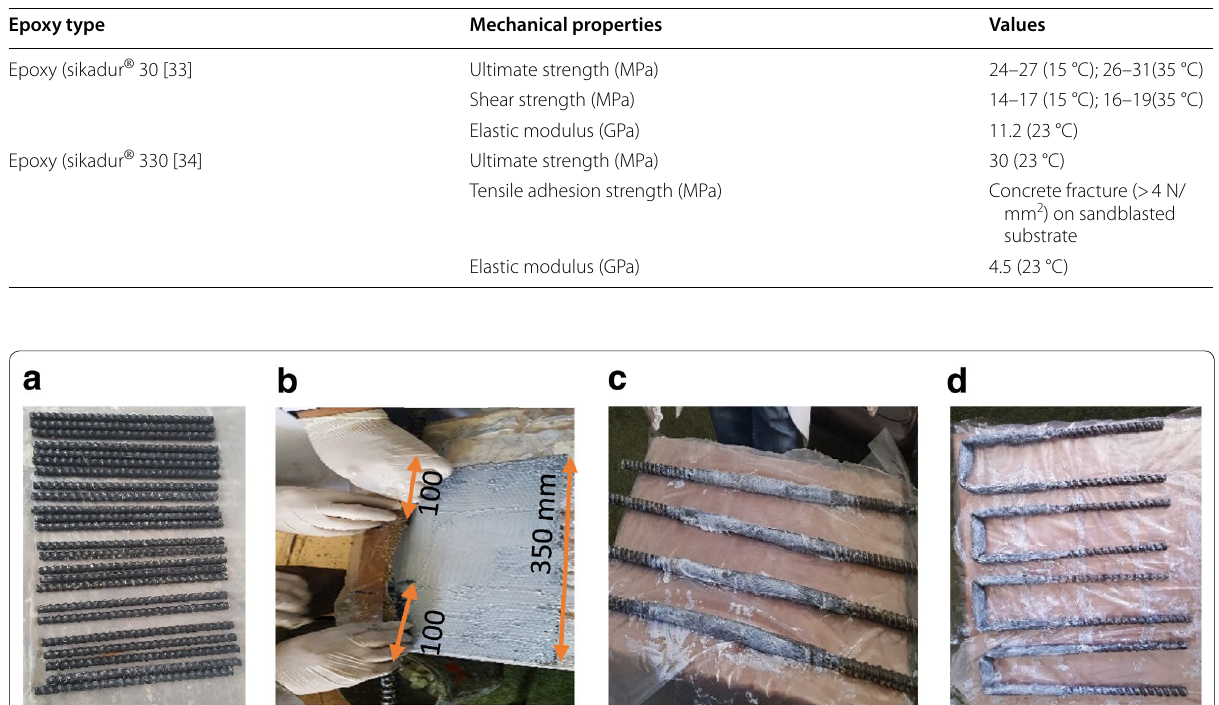
Table 4 Properties of the epoxy.